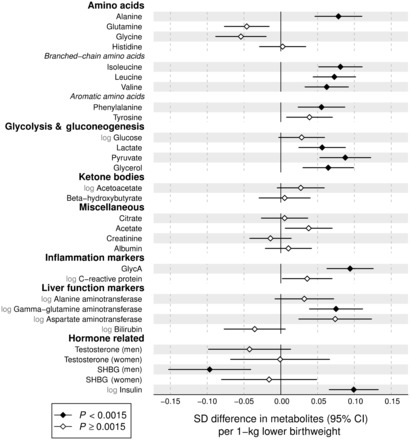
Birthweight associations with adult metabolite and hormonal concentrations. The associations were adjusted for sex, gestational age and age at blood sampling, and meta-analysed for 18 288 individuals from seven cohorts. Association magnitudes are in units of 1 SD metabolite concentration per 1 kg lower birthweight. Error bars denote 95% confidence intervals. Filled diamonds indicate P < 0.0015. Results for individual cohorts are shown in Figure S5, available at IJE online. GlycA, glycoprotein acetyls; SHBG, sex-hormone binding globulin.